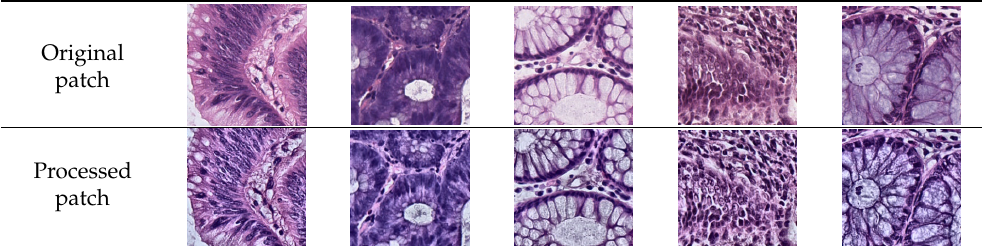
Table 2. Number of parameters in different